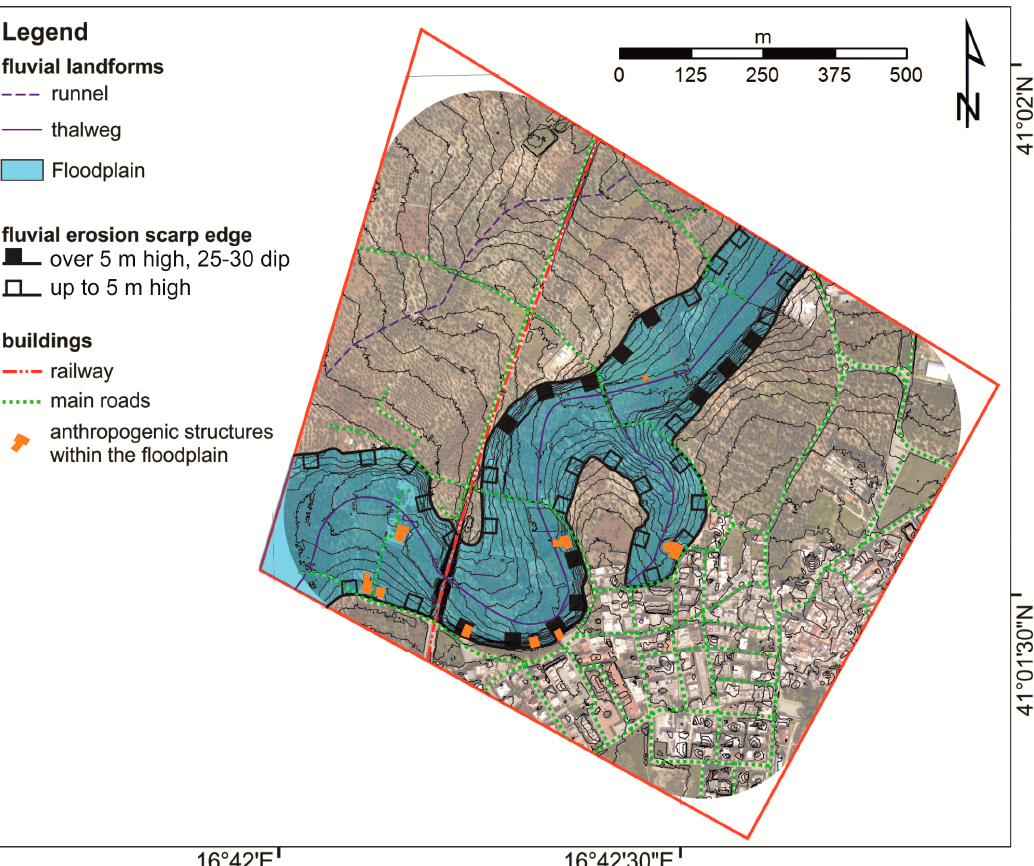
Figure 9. Geomorphological integrated map of the study area showing morphological features and the floodplain surface of Lama Lamasinata.